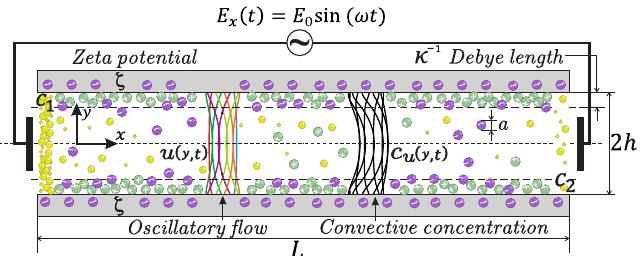
Figure 1. Schematic depiction for mass transport due to an oscillatory electroosmotic